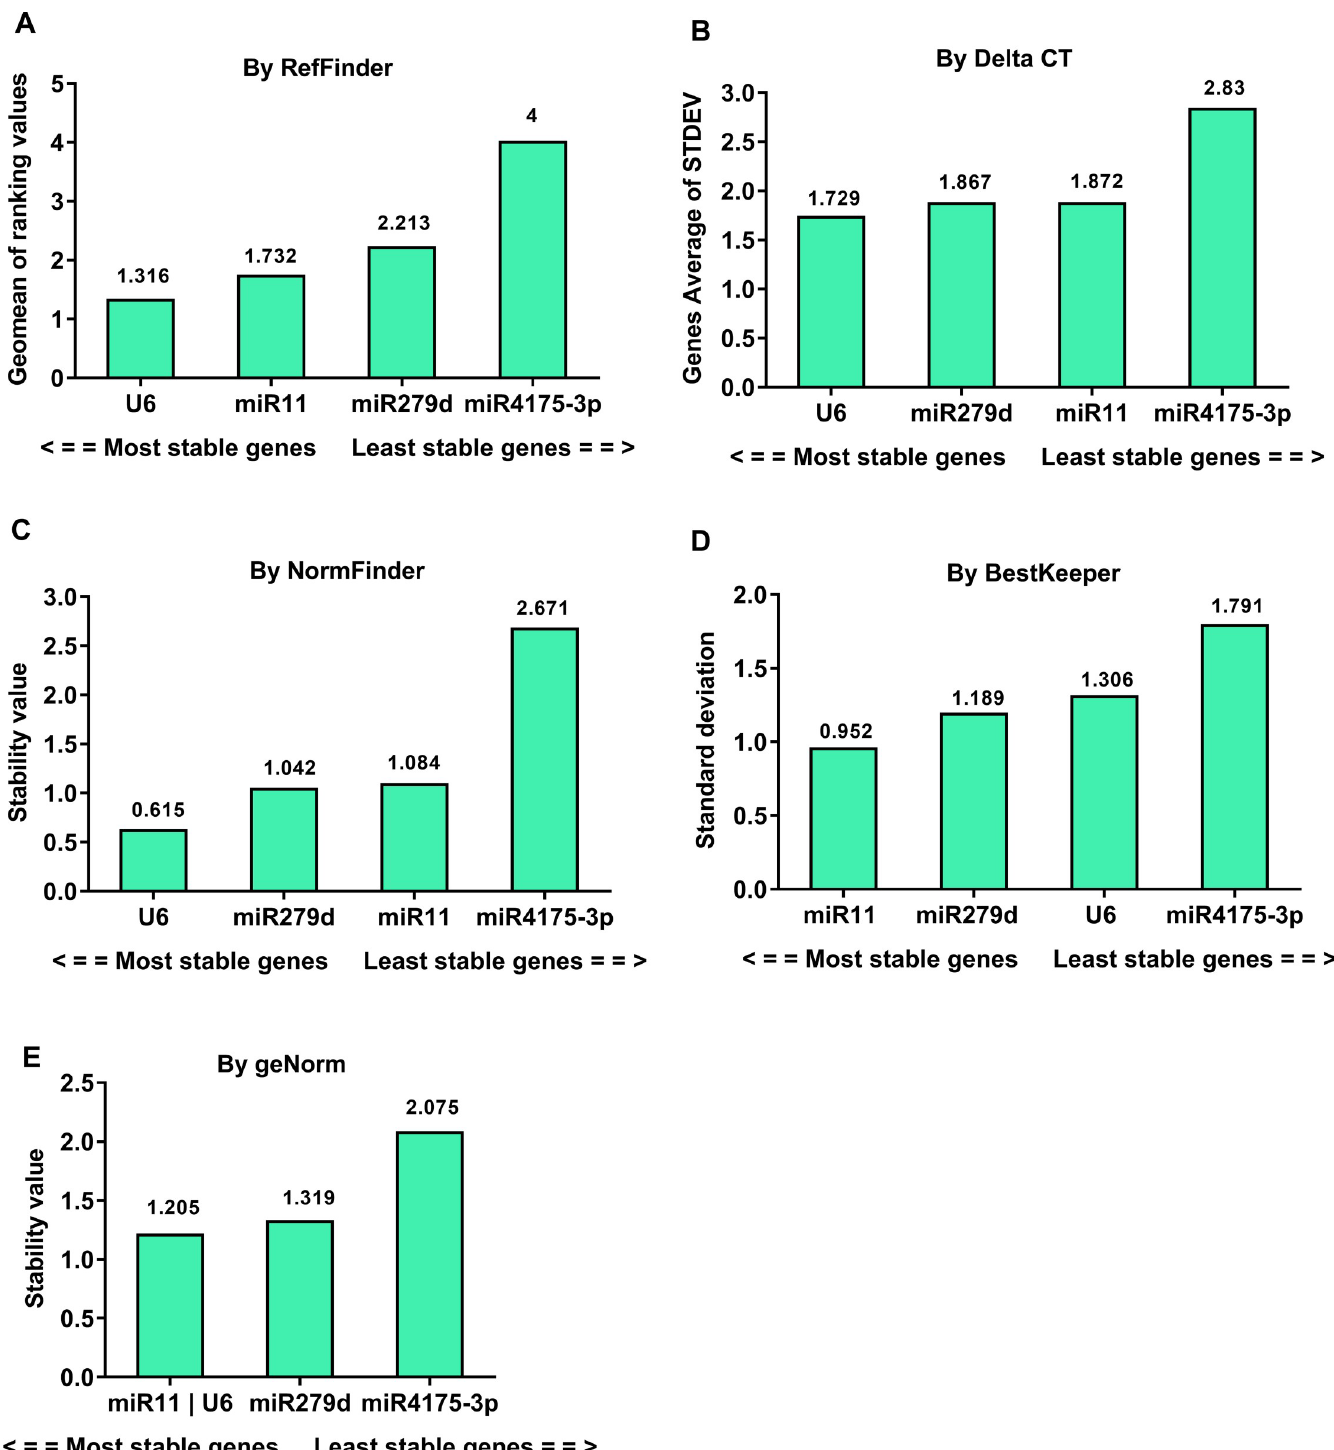
Fig 3. Stability analysis of candidate reference genes in the tissues of G88 strain. The Ct values derived from samples including brain, midgut, silk gland, Malpighian tubule, fat body, hemolymph, and the remaining tissues of 4 th instar larvae were used to calculate the stability values by different algorithms. A lower value indicates a more stable candidate gene as reference gene (numbers reported above the